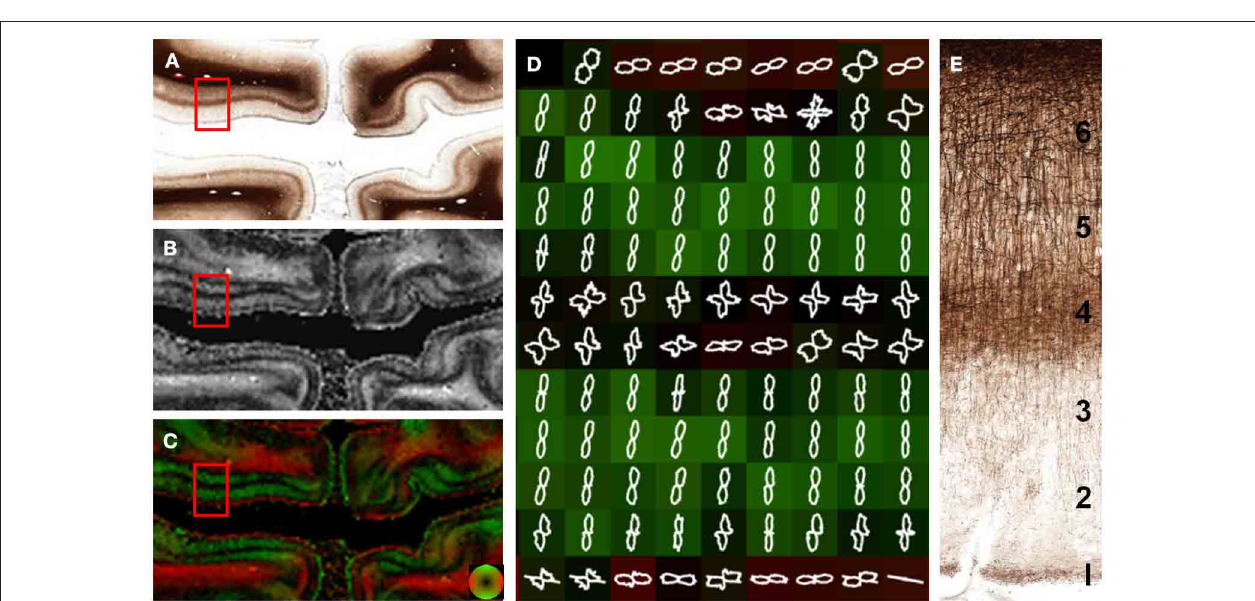
(D) along the white-gray matter interface (dotted line). In cortex at the deepest portion of the sulci, the cortex has a mixture of radial and tangential fibers (C) . The white matter fibers just below the deepest part of the sulci are oriented tangentially, consistent with the U-shaped association fibers.